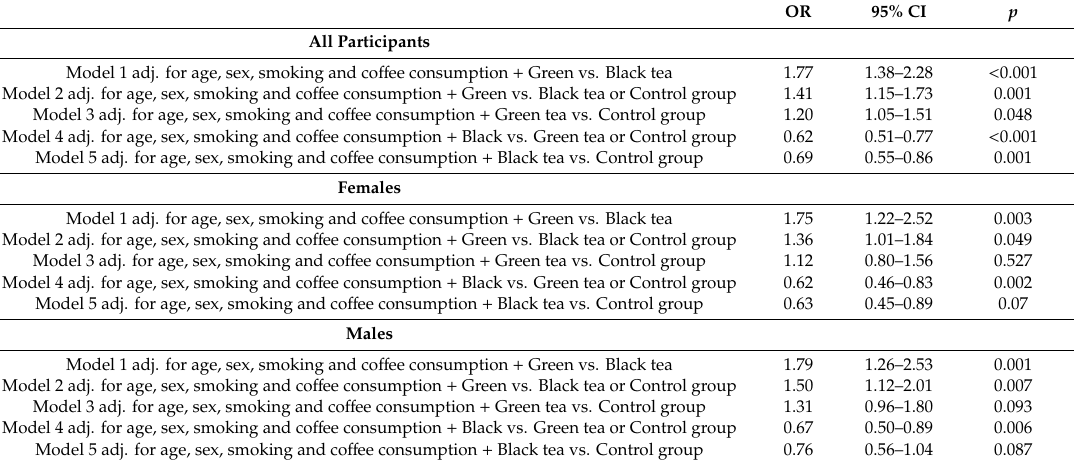
Table 3. Results from logistic regression models that evaluated the association between the type (Green or Black) of tea consumed with successful aging index (i.e., above or below the median value 3.58) (dependent variable) among ATTICA and MEDIS study participants, separately for males and